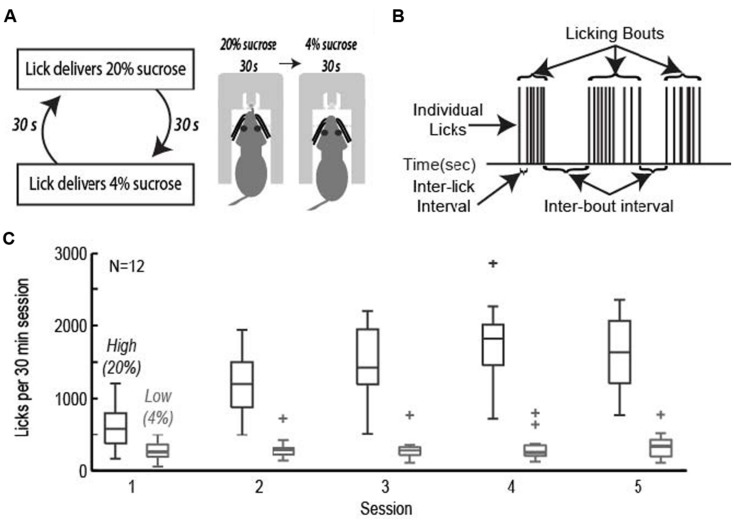
The operant licking task. (A) Rats licked on a single spout and received access to solutions containing relatively high (20%, w/v) or low (4%) sucrose. The two fluids were presented in alternating 30-s epochs at the same spout. (B) Animals consumed sucrose by emitting bouts of licks. Key measures of licking “microstructure” are indicated. (C) Acquisition of learning. Rats learned to actively suppress licking for the low value (4%) sucrose solution while gradually increasing intake for the high value (20%) sucrose solution across the first five sessions of the task.